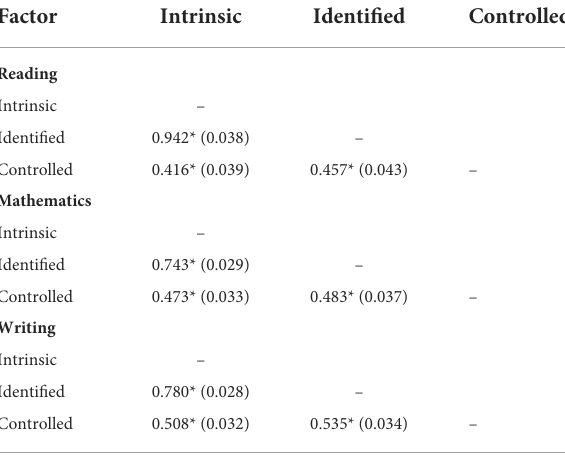
TABLE 7 Correlations between